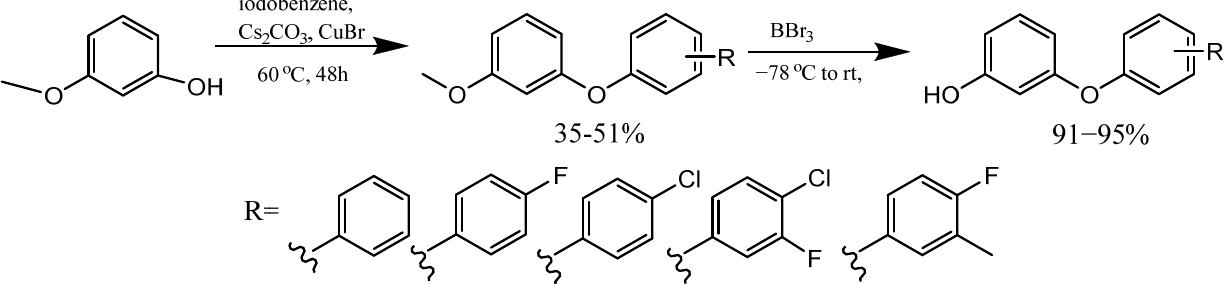
Scheme 12. Synthesis of m-methoxy phenols with iodobenzene derivatives using Cs 2 CO 3 and